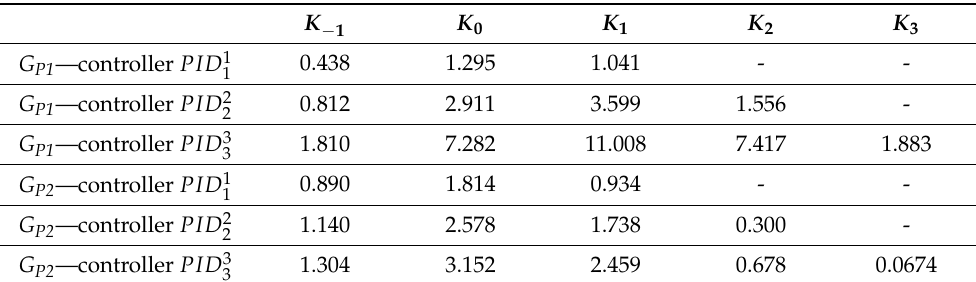
Table 2. The calculated controller